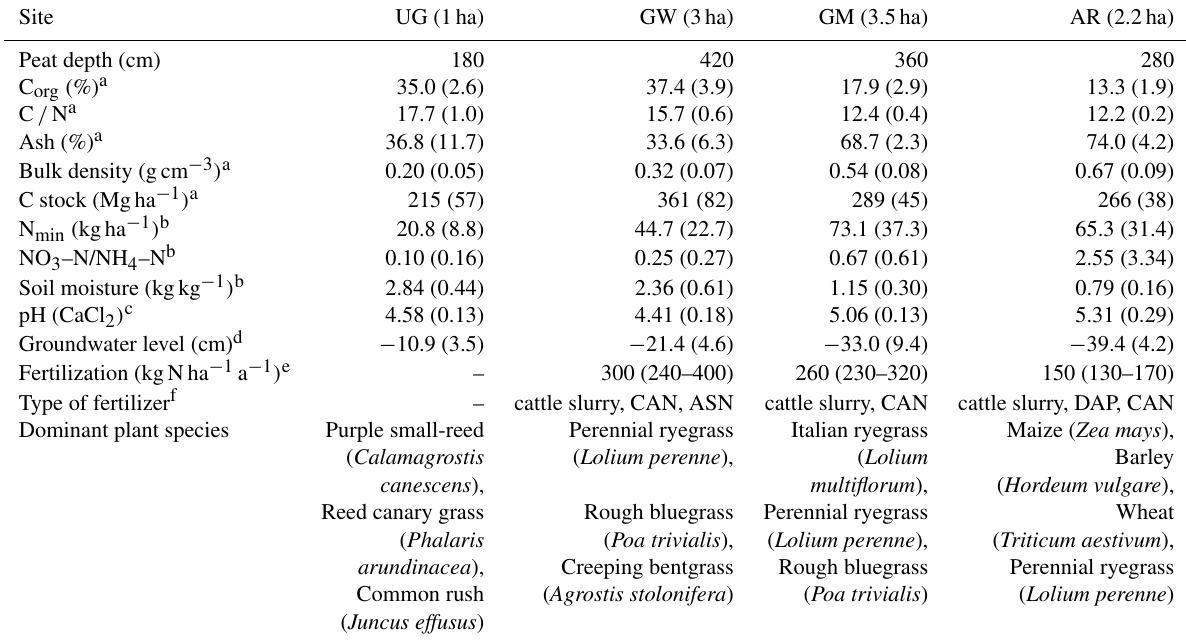
Table 1. Soil and land use characterization of the experimental sites (UG: unutilized grassland, GW: grassland wet, GM: grassland moist, AR: arable land). Numbers in brackets represent standard